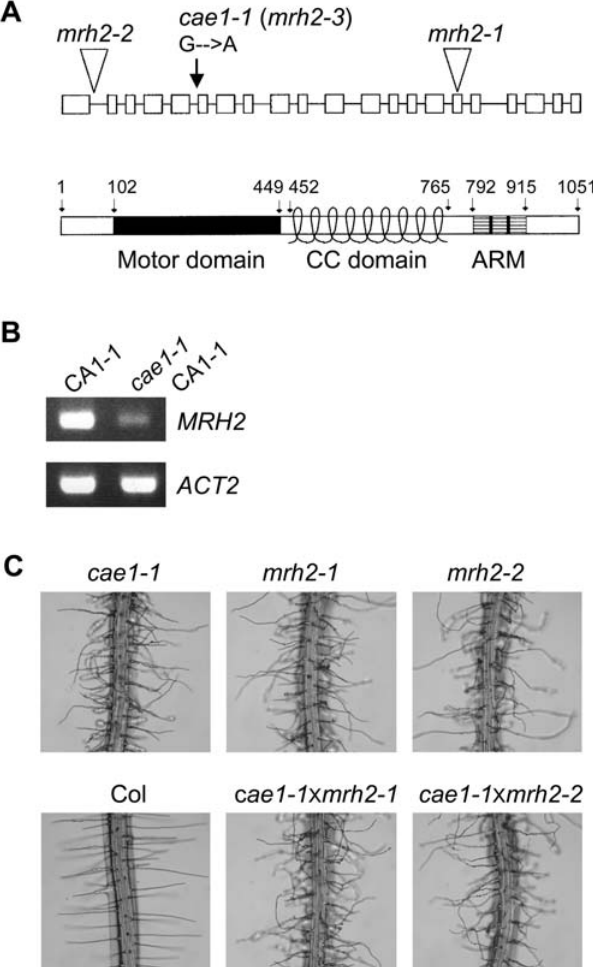
Figure 2. Molecular characterization of the CAE1/MRH2gene. (A) A schematic representation of the CAE1/MRH2 genomic structure and domain organization. Upper panel , the CAE1/MRH2 genomic structure. Solid boxes indicate exons and solid lines indicate introns. The cae1-1 mutation site and the T-DNA insertion sites for mrh2-1 and mrh2-2 were indicated. cae1-1 was renamed to mrh2-3 . Lower panel , domain feature of the 1051 amino acid-containing MRH2 protein. Numbers above indicate the positions of amino acids. Motor domain, the catalytic domain of kinesin motor (102–449); CC, coiled-coil (452–765); ARM, the ARM repeat domain (792–915). (B) RT-PCR analysis of MRH2